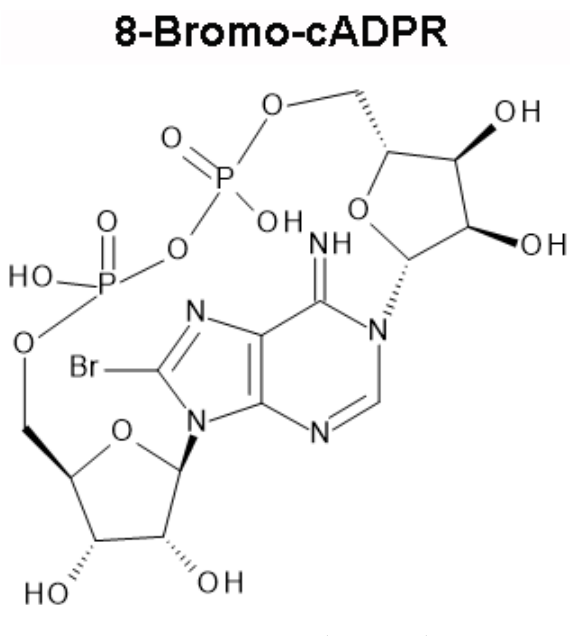
Figure 1. 8-Bromo-cyclic ADP-ribose.